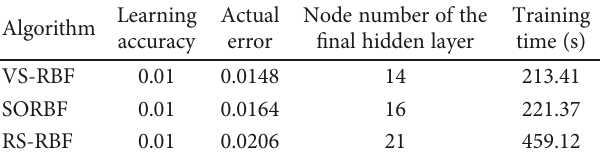
Table 1: Comparisons of performances in approximating SIF. Learning Algorithm accuracy